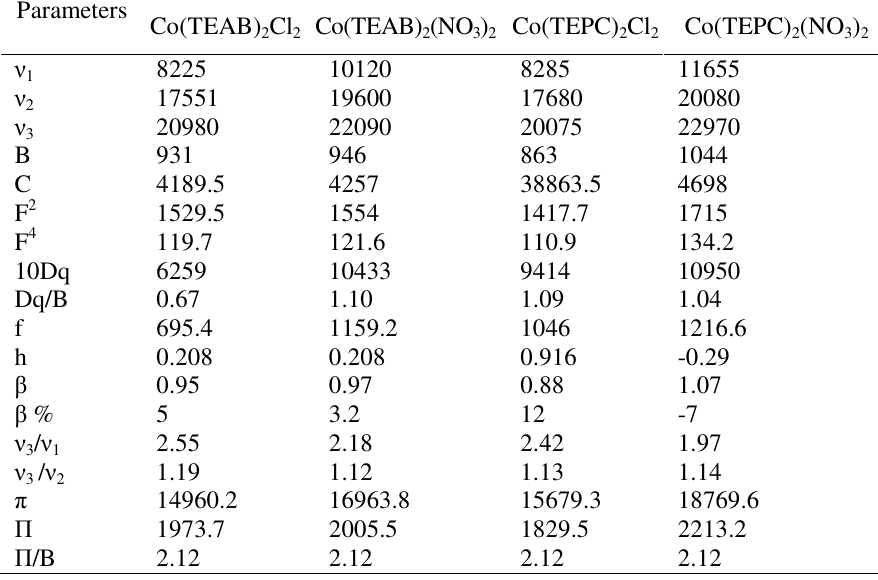
Table 2. Electronic spectral data and compound values of some ligand field parameters for Co (II) complexes